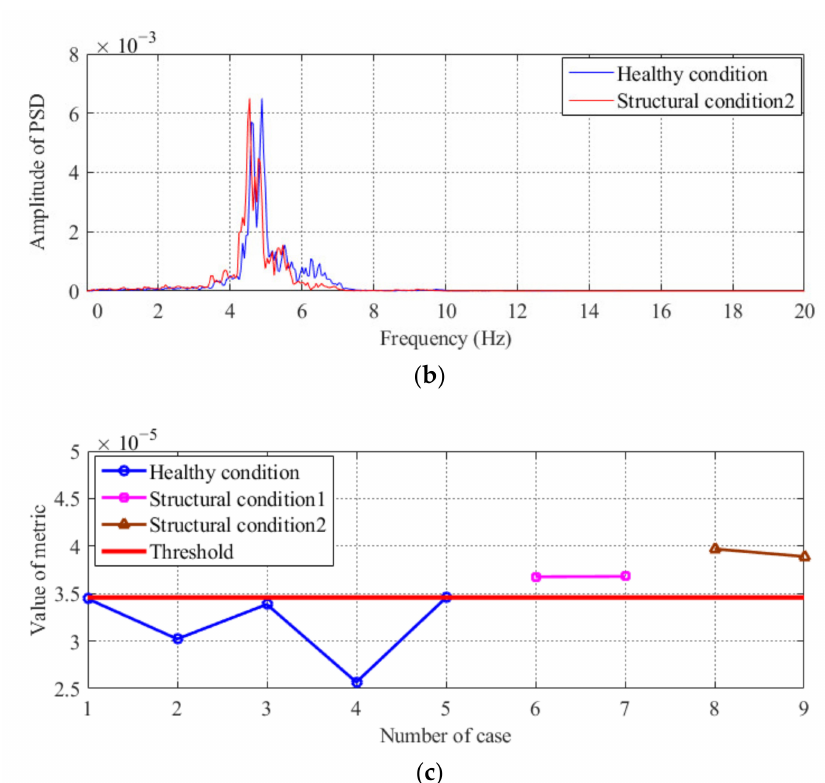
Figure 14. Results of condition diagnosis for the actual bridge by using the proposed method: auto-PSD obtained by using the acceleration response of the #2 sensor under ( a ) structural condition 1 and ( b ) structural condition 2 and ( c ) condition diagnosis results for the actual beam